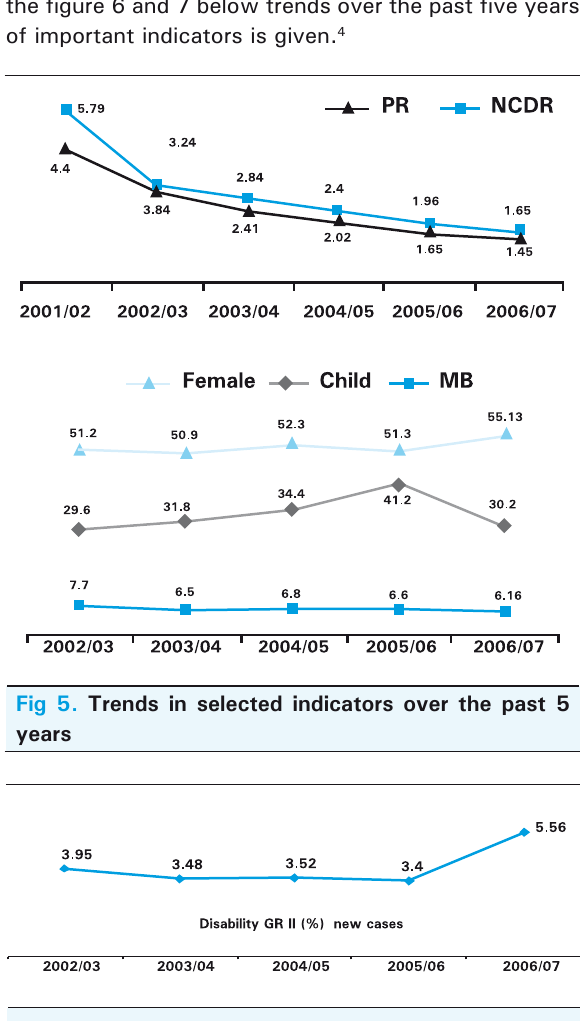
Fig6. trends in DR GR II among new